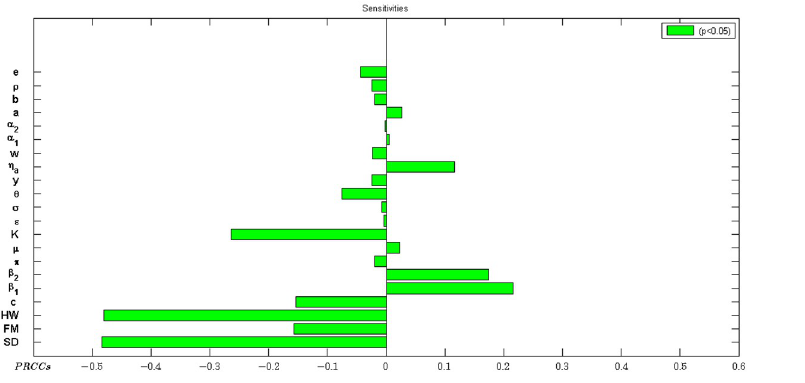
Fig 10. Sensitivity of parameters with respect to R o